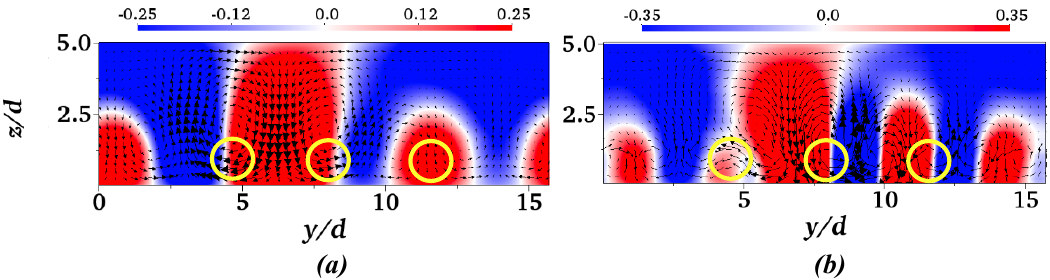
Figure 19. Reconstructed 3D POD modes from 2D Fourier-POD modes at yz plane, x = 7.85 d , ( a ) m = 0, k y d = 1.6, ( b ) m = 1, inverse FFT, k y d = 1.6. Contours— ˜ φ u , in-plane vectors— ˜ φ v , ˜ φ w . inverse FFT ∀ ∀ Thick yellow circles—turbine locations.